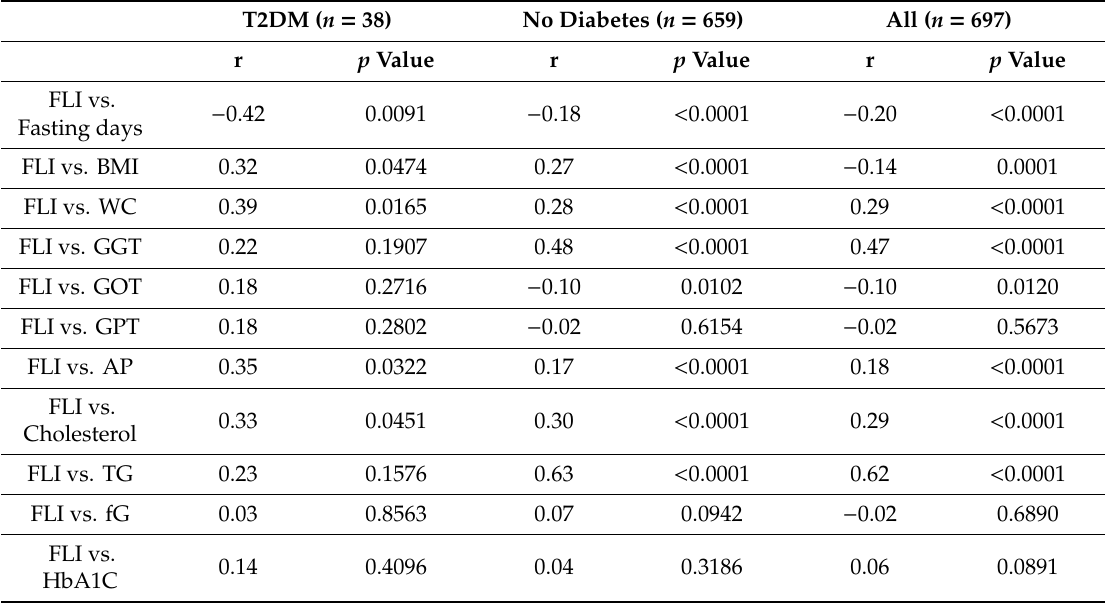
Table 3. Correlation analyses, overall and for subjects with and without